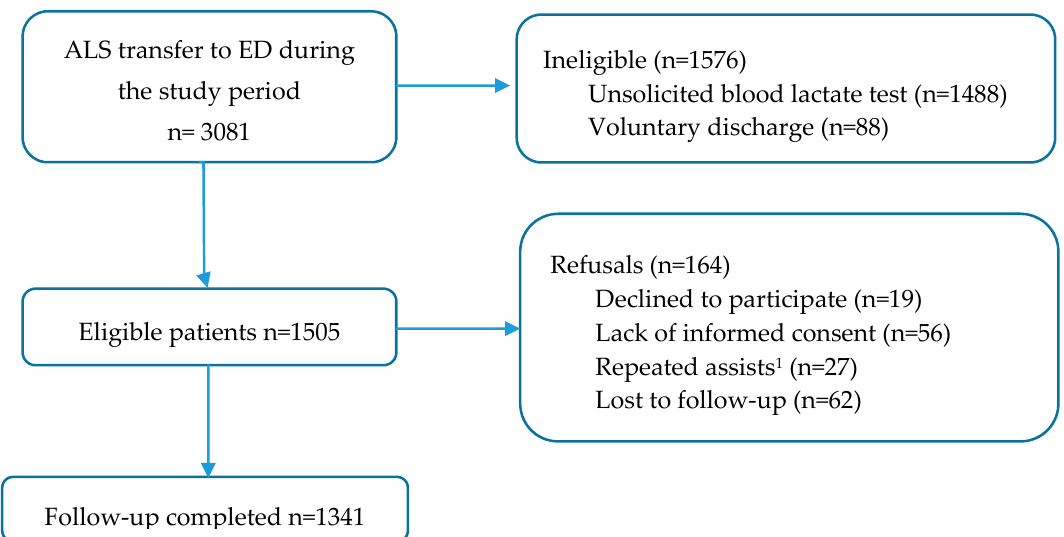
Figure 1. Flowchart of the participants in the study. 1 In the case of more than one attendance at the